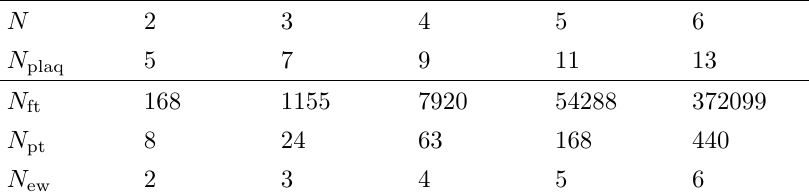
Table 1. Resource scaling of entanglement certification for the systems sketched in figure 4. The number of measurements required for full tomography of the system L , with Hilbert space dimension d L , grows exponentially with system size according to N ft = d 2 − 1 . Full-fledged entanglement L measures on a subsystem A can be computed by expressing the reduced density matrix of A as a mixture of SSs H A ( Z A ) . However, partial tomography of the reduced density matrix of subsystem A is also typically plagued by exponentially growing cost (see, e.g., [57] for an example in 1+1D). Specifically, the number of measurements necessary is given by N pt = d 2 − 1 where d A A is the dimension of the chosen SS H A ( Z A ) (illustrated here for the largest superselection sector). In contrast, the number of independent measurements to evaluate the entanglement witness ˆ C defined in equation (3.6) only scales polynomially as N ew = ( N plaq − 1) / 2 . Depending on the specific scenario, this number can be further decreased, e.g., by parallel measurements of commuting summands of ˆ C . As these figures illustrate, entanglement witnesses for LGTs can drastically reduce the resource cost of entanglement